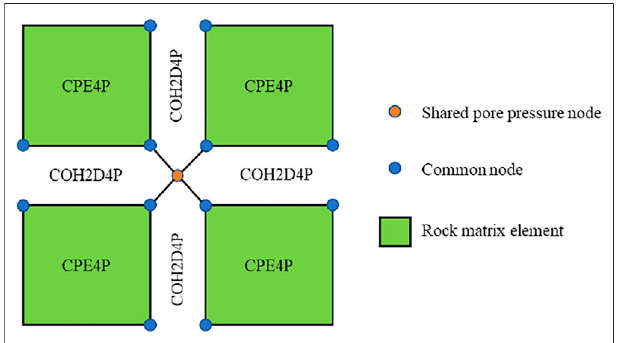
FIGURE 3 | Schematic diagram of cohesive elements sharing one seepage node.